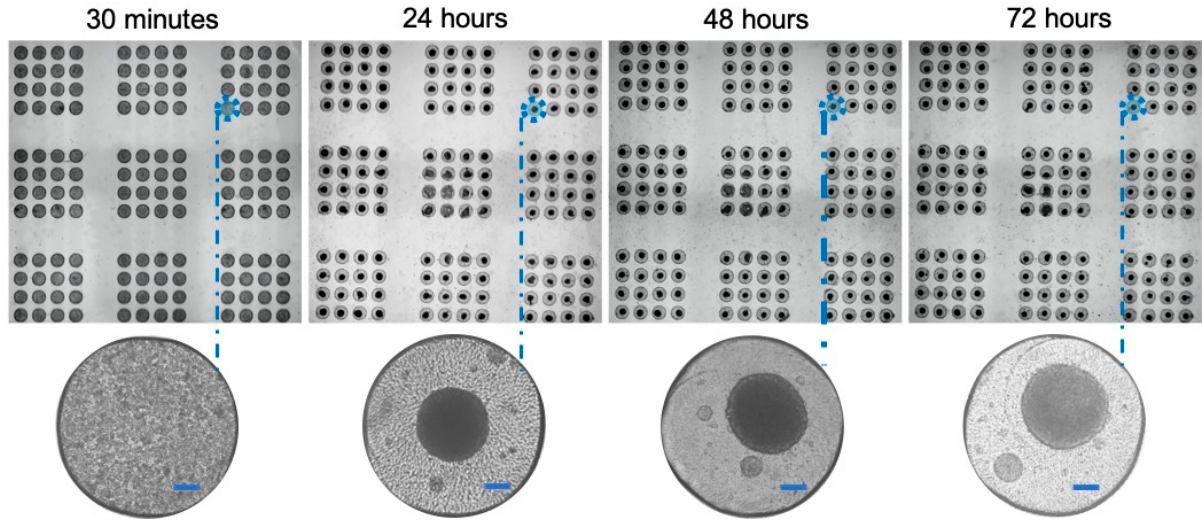
Figure 3. Formation of uniform and compact spheroids of colon cancer cell line HCT-116 in the microwell array over time. Scale bars = 100 μ m.